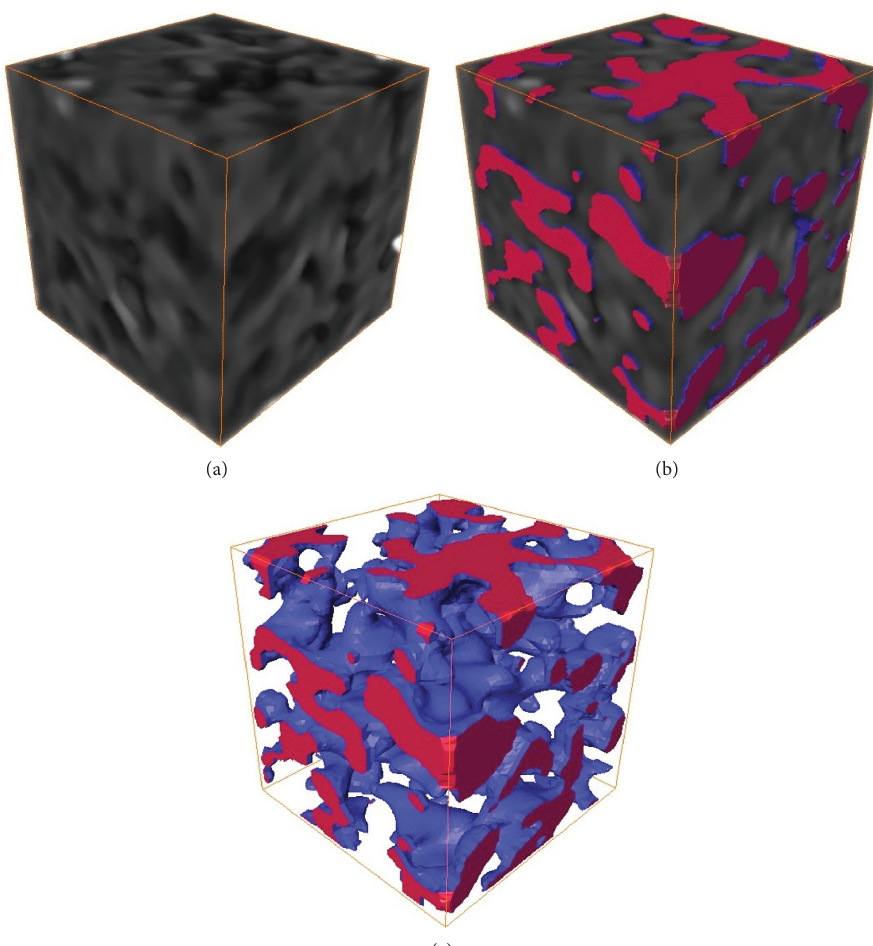
Figure 6: Model of coal’s micropore structure in model P